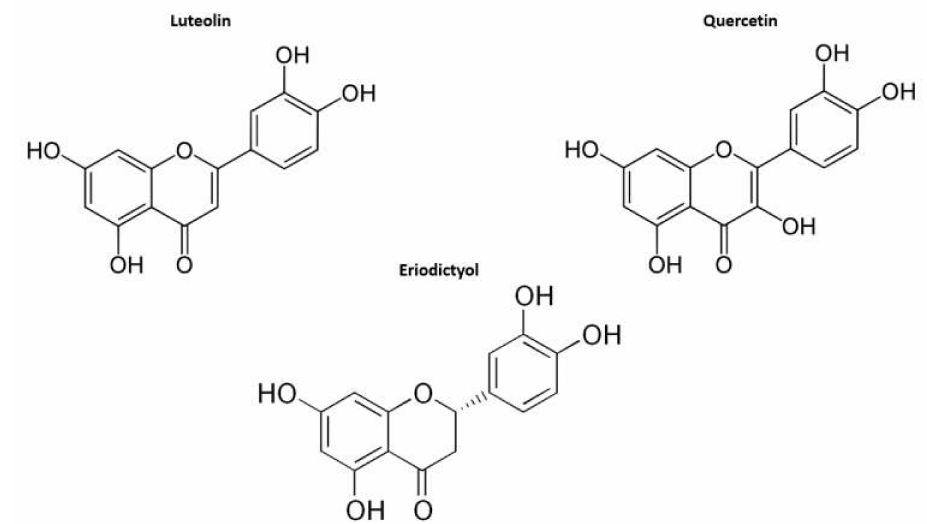
Figure 7. Similarity between chemical structures of the luteolin, quercetin, and eriodictyol. Luteolin, quercetin, and eriodictyol have been identified in the recent supercomputer SUMMIT drug-docking screen as top candidate inhibitors of the SARS-CoV-2 spike-protein–human ACE2 receptor interface–ligand binding complex [42], while Luteolin and quercetin have been identified as potent inhibitors of the SARS-CoV infection